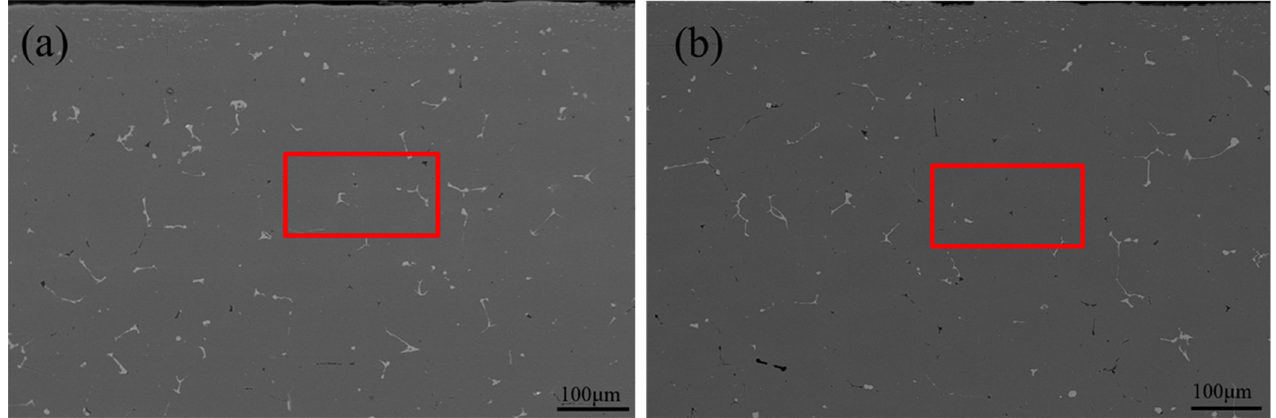
Figure 9. ( a ) and ( b ) are brazed and aged specimens, respectively. The transmission electron mi- Figure 9. ( a , b ) are brazed and aged specimens, respectively. The transmission electron microscopy croscopy (TEM) of samples is obtained in the red box (core layer). (TEM) of samples is obtained in the red box (core Table 2. Mechanical properties of 4343/3003/6111/3003 Al clad sheet in different conditions. Specimen